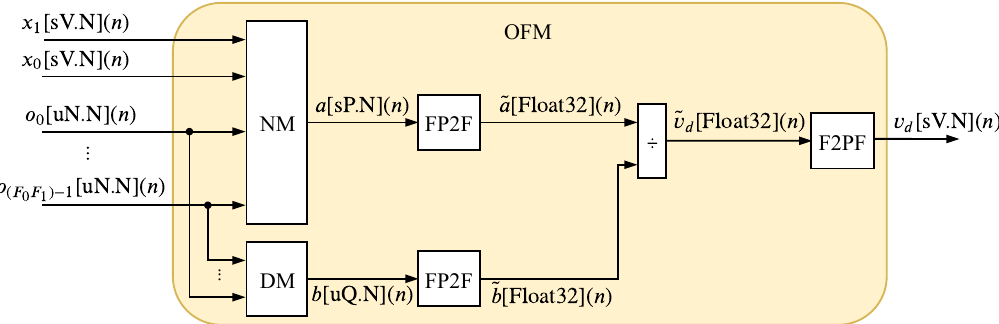
Figure 9. Hardware architecture of the OFM.